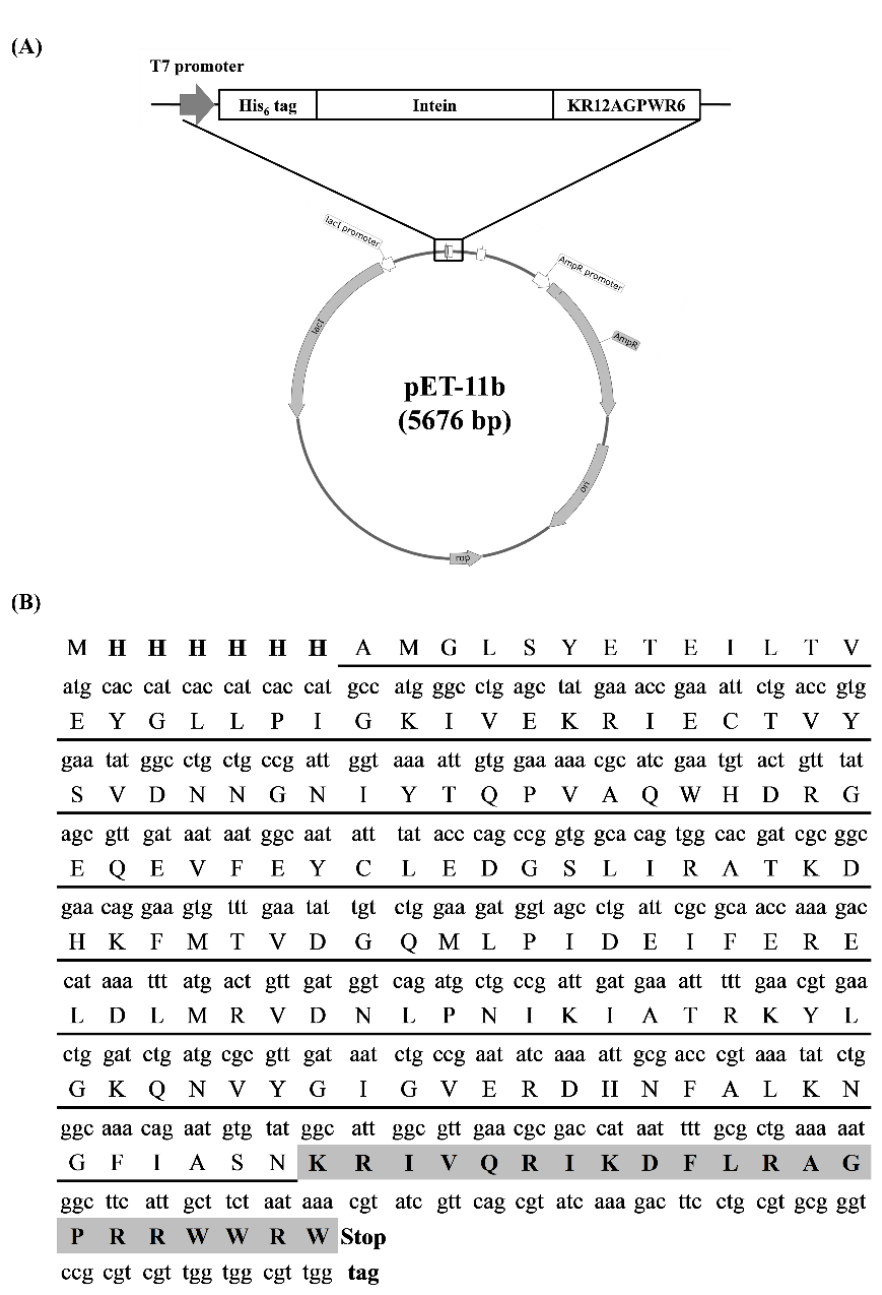
Figure 1. Gene map of the recombinant plasmid pET11b-His6-intein-KR12AGPWR6. ( A ) The illustration of inserted His6-intein-KR12AGPWR6 sequence. ( B ) Optimized DNA sequence and codon map. His6-tag are in bold; the sequence of intein is underlined; the sequence of KR12AGPWR6 is shaded.